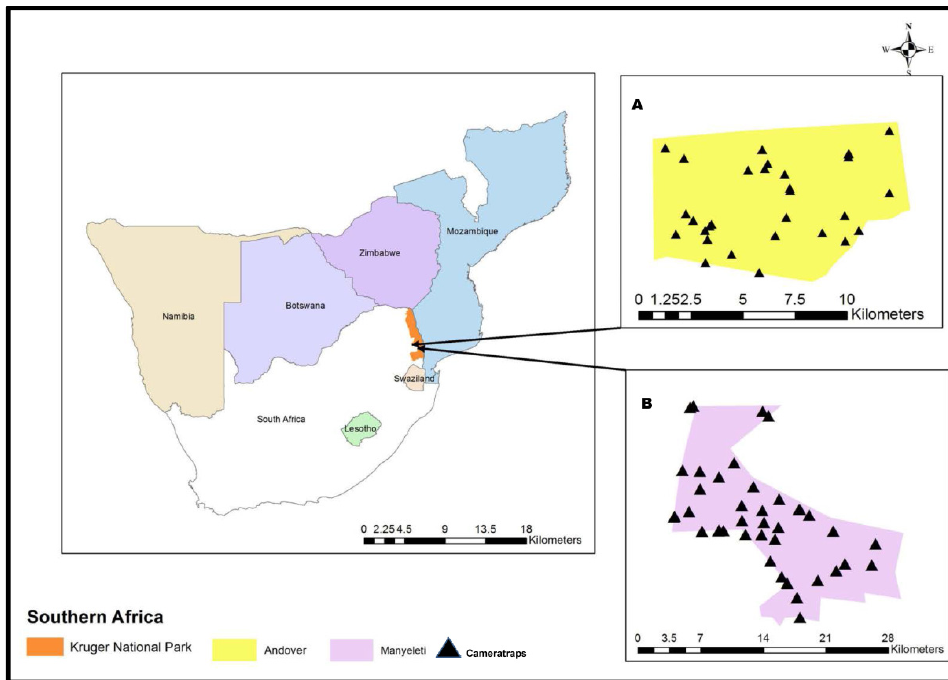
Figure 1. Camera trap locations in Andover (A), and Manyeleti (B) nature reserves, Mpumalanga Province, South Africa from 2015–2017.